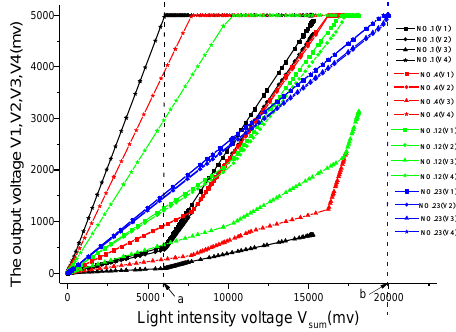
Figure 8. The output voltage of each channel at different PSD incident light position.